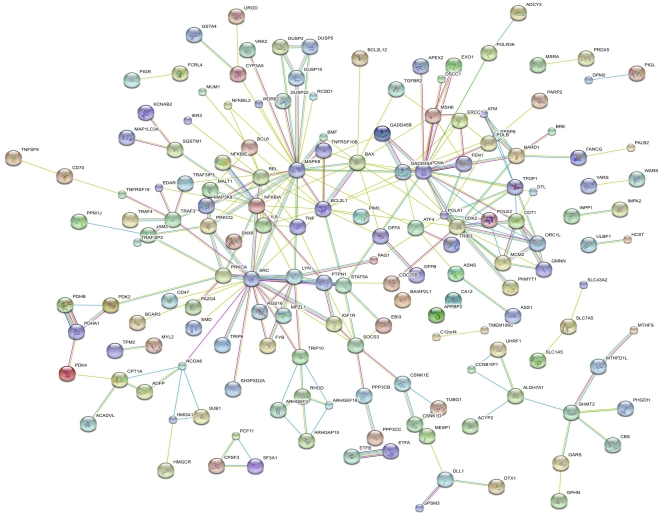
Predicted interaction networks of genes regulated during HIV-1 infection.Differentially regulated genes are represented in the links predicted using STRING (http://string.embl.de/). Predicted interactions represent both direct and indirect associations that are derived from four different sources: genomic context, high throughput experiments, conserved co-expression, and previous findings from the literature. The nature of the supporting evidence is indicated by the color lines: green represents neighborhood; red, gene fusion; blue, co-occurrence; black, co-expression; purple, previous experiments; turquoise, database; yellow, text mining; and aqua, homology.